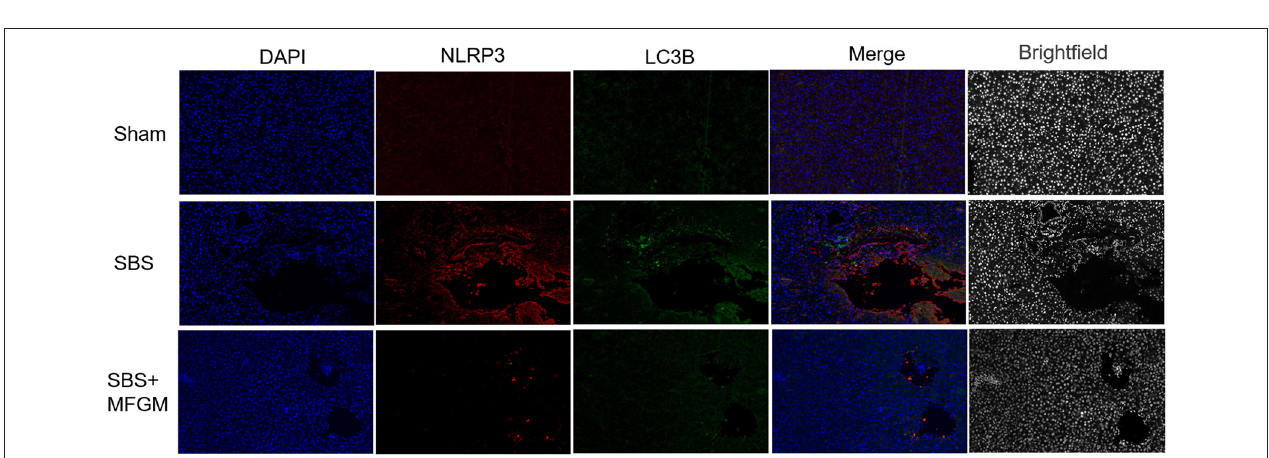
FIGURE 4 | Western blotting of the autophagy pathway proteins in the liver (A) ; relative expression of autophagy proteins in the liver (B) . Data were presented the means ± SD ( n = 5-7), group differences were determined by ANOVA test followed by Tukey’s post hoc test, and * P < 0.05 indicates a difference between the two groups, N.S. indicates no significance. LC3, microtubule-associated protein1 light chain 3; MFGM, milk fat globule membrane; SBS, short bowel syndrome.